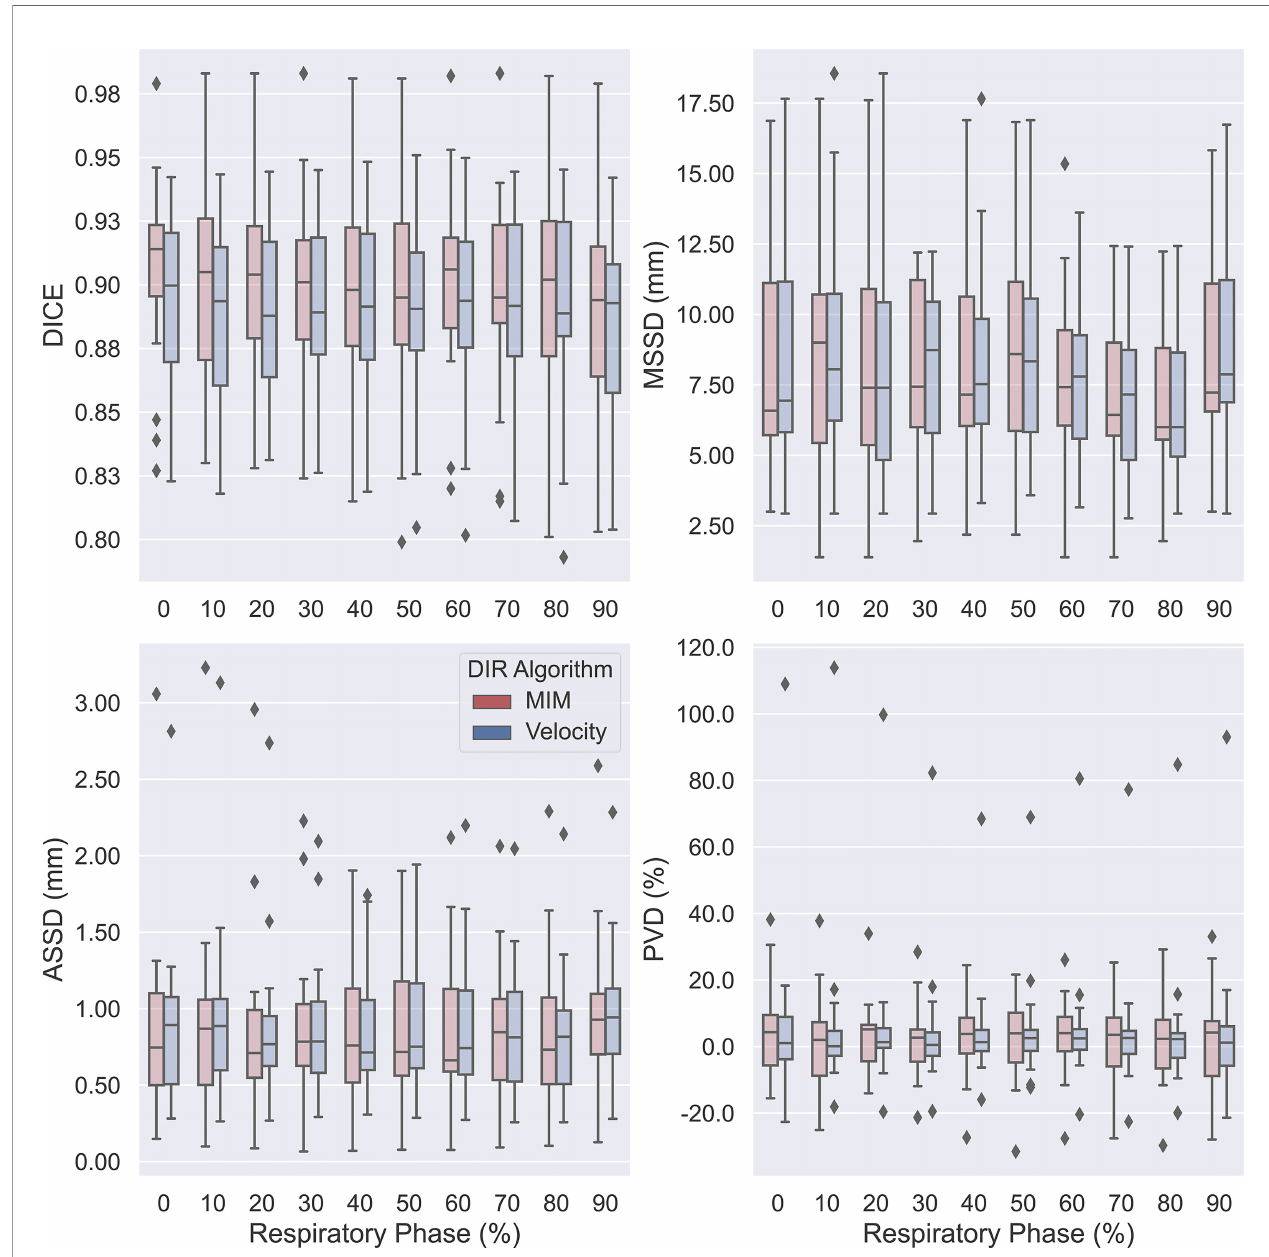
FIGURE 4 | Boxplots comparing accuracies of auto-propagated internal gross tumor volumes (AP-IGTVs) from the two employed deformable image registration (DIR) algorithms — MIM (red) and Velocity (blue) — relative to their corresponding ground-truth internal gross tumor volumes (GT-IGTVs) in terms of Dice coef fi cient (DICE), maximum symmetric surface distance (MSSD), average symmetric surface distance (ASSD), and percent volume difference (PVD) between different respiratory phases for the study cohort. On each box, the central mark indicates the median, and the top and bottom edges of the box indicate the 25th and 75th percentiles,